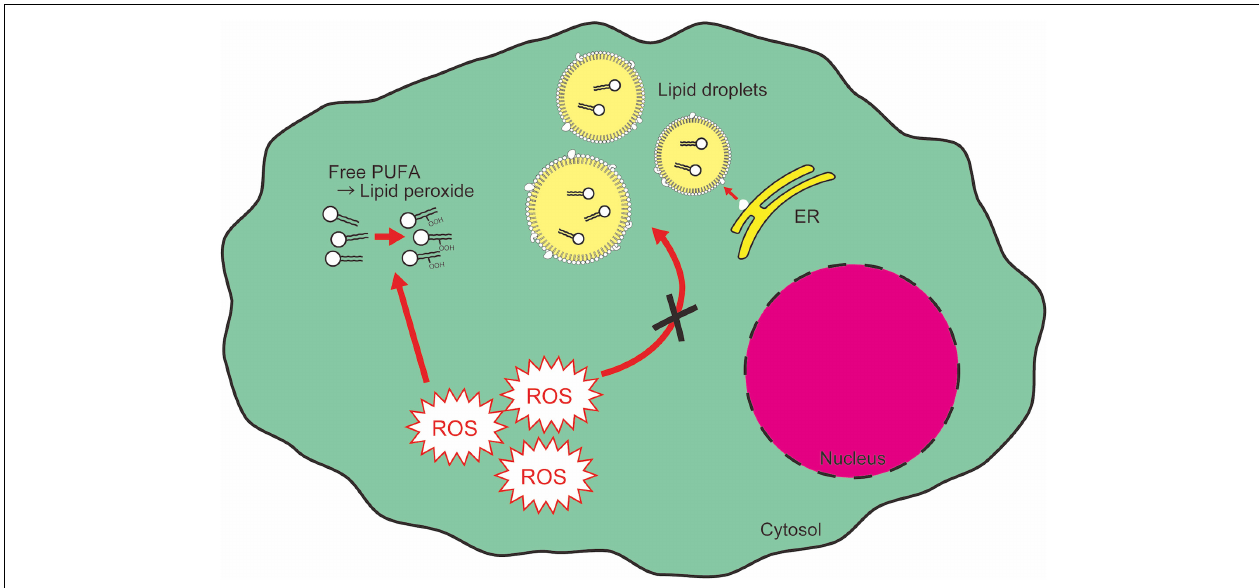
FIGURE 5 | Lipid droplets segregate and protect PUFAs from cytotoxic peroxidation. Free PUFAs are susceptible to oxidation and converted into lipid peroxides which cause cytotoxic insult as a second messenger of ROS signaling. ER, endoplasmic